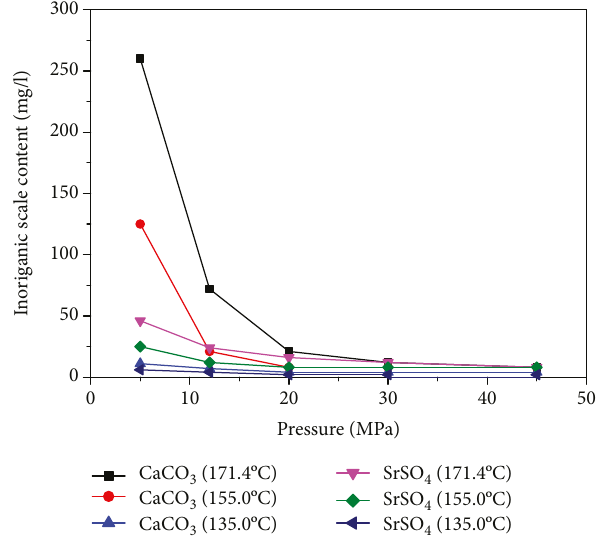
Figure 4: Scaling quantity curve of BS8 formation fl